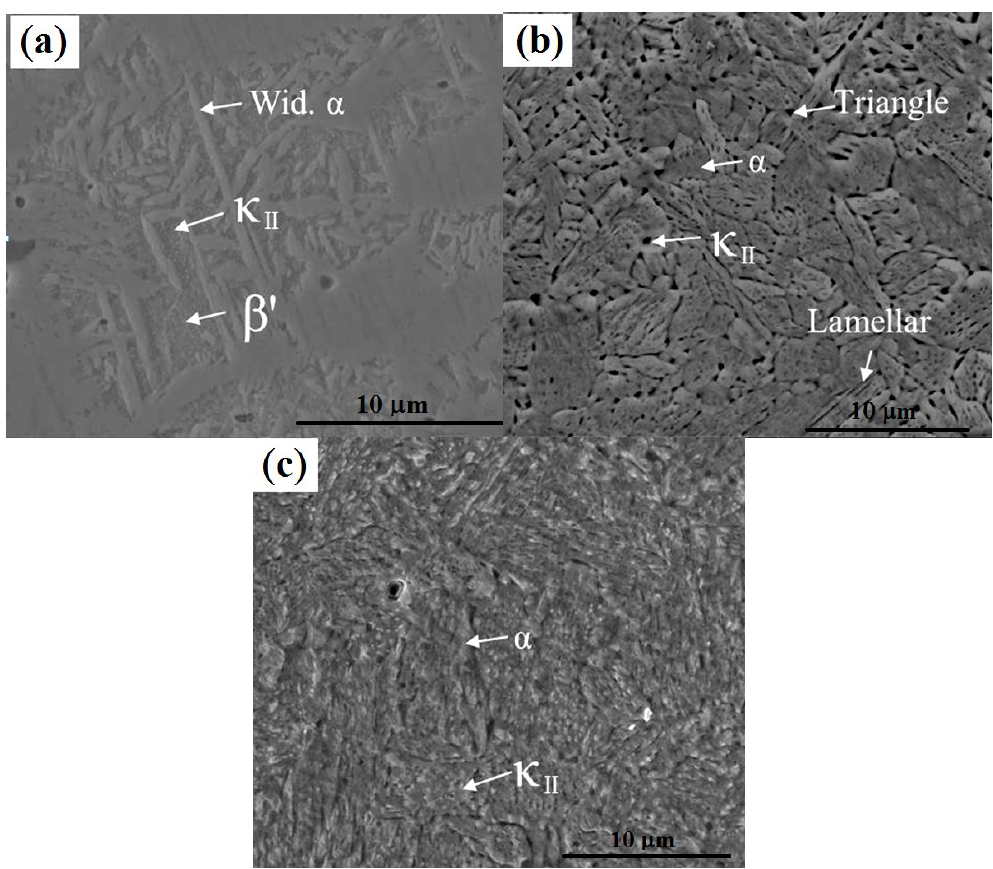
Figure 3. The microstructures of FSP NAB and post heat treated conditions (Region A in Figure 2). ( a ) FSPed NAB alloy. ( b ) Annealing 2 h. ( c ) Annealing 4 h.